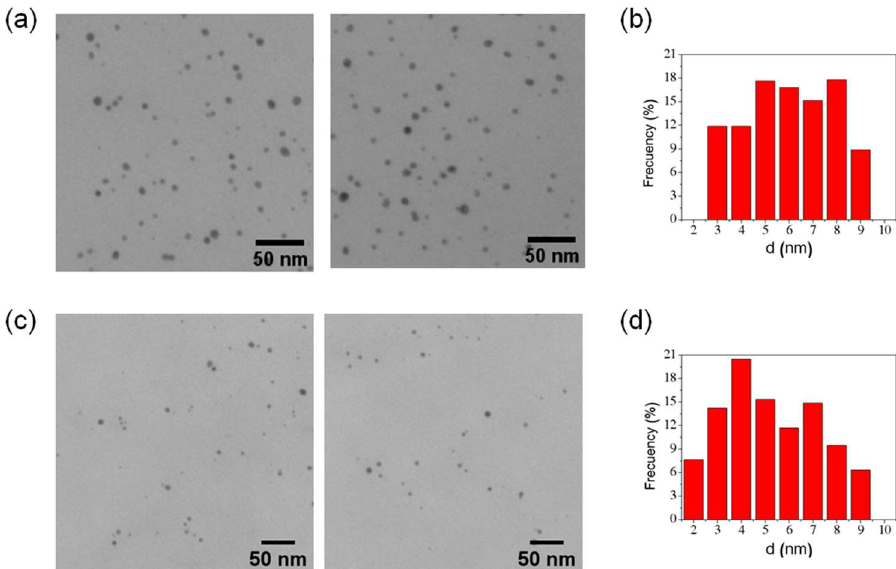
Figure 4. TEM images of FT-AuNP samples without staining. ( a ) FTH-AuNP, ( b ) size distribution of FTH-AuNP samples, ( c ) FTL-AuNP and ( d ) size distribution of FTL-AuNP samples. Scale bar 200 nm.